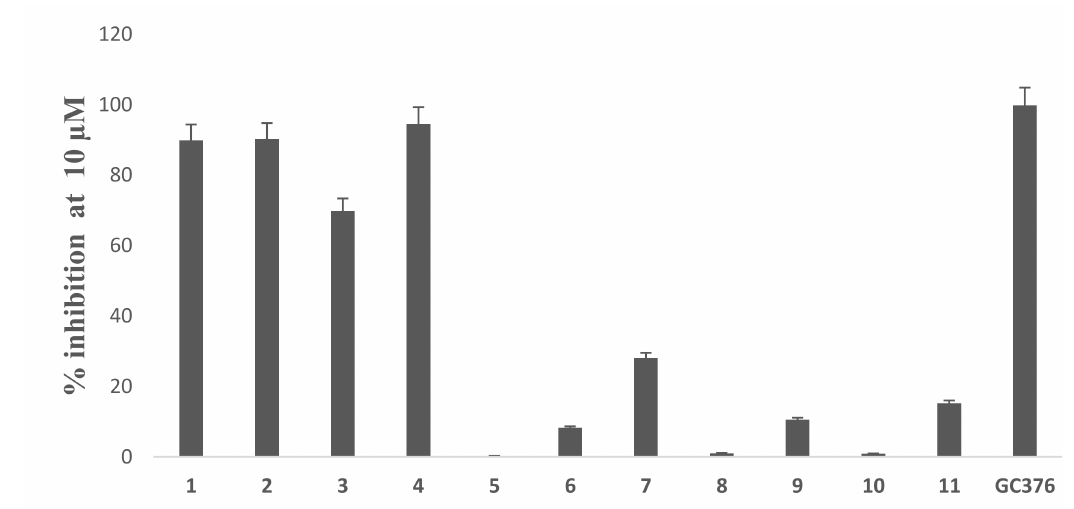
Figure 2. Dose-response curves of compounds 1 , 2 , 4 and the positive control GC376.